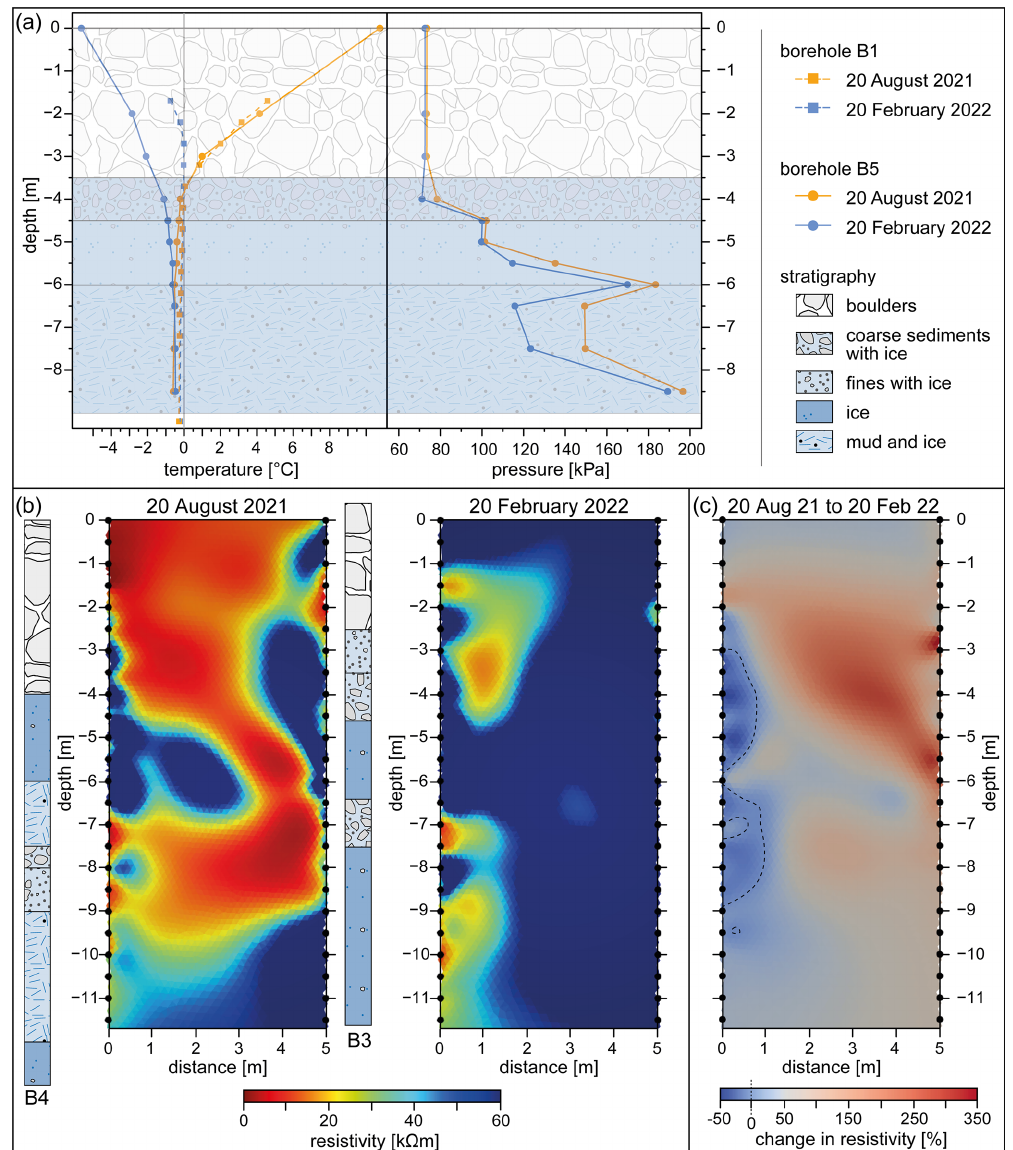
Figure 3. (a) Left: Borehole temperatures in B1 (squares) and B5 (dots) on 20 August 2021 (yellow) and 20 February 2022 (blue), between 0 and 9m depth. Right: Piezometer pressure data measured in B5 on 20 August 2021 (yellow) and 20 February 2022 (blue). The stratigraphy of B5 is shown in the background. The source for the temperature data of borehole B1 is the Swiss Permafrost Monitoring Network (PERMOS). (b) Cross-borehole resistivities on 20 August 2021 (left; 6 iterations, RMSE 1.06) and on 20 February 2022 (centre; 5 iterations, RMSE 1.04). The stratigraphies of B4 and B3 are shown beside the 20 August 2021 resistivity profiles to underline the consistency between stratigraphies and resistivities (for legend see Fig. 3a). (c) Percentage change of resistivities between 20 August 2021 and 20 February 2022. The black- dashed line indicates the 0% contour